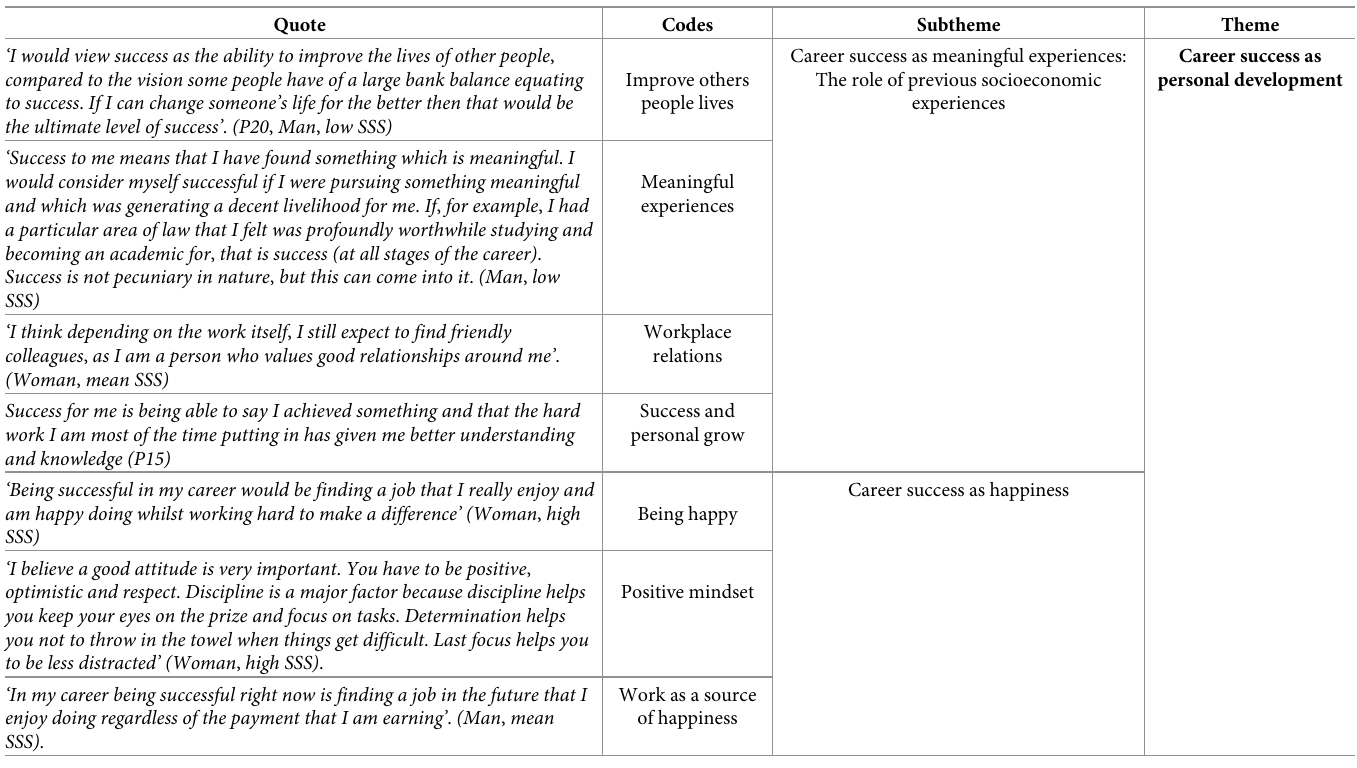
Table 2. “Career success as personal development”: Subthemes, codes and